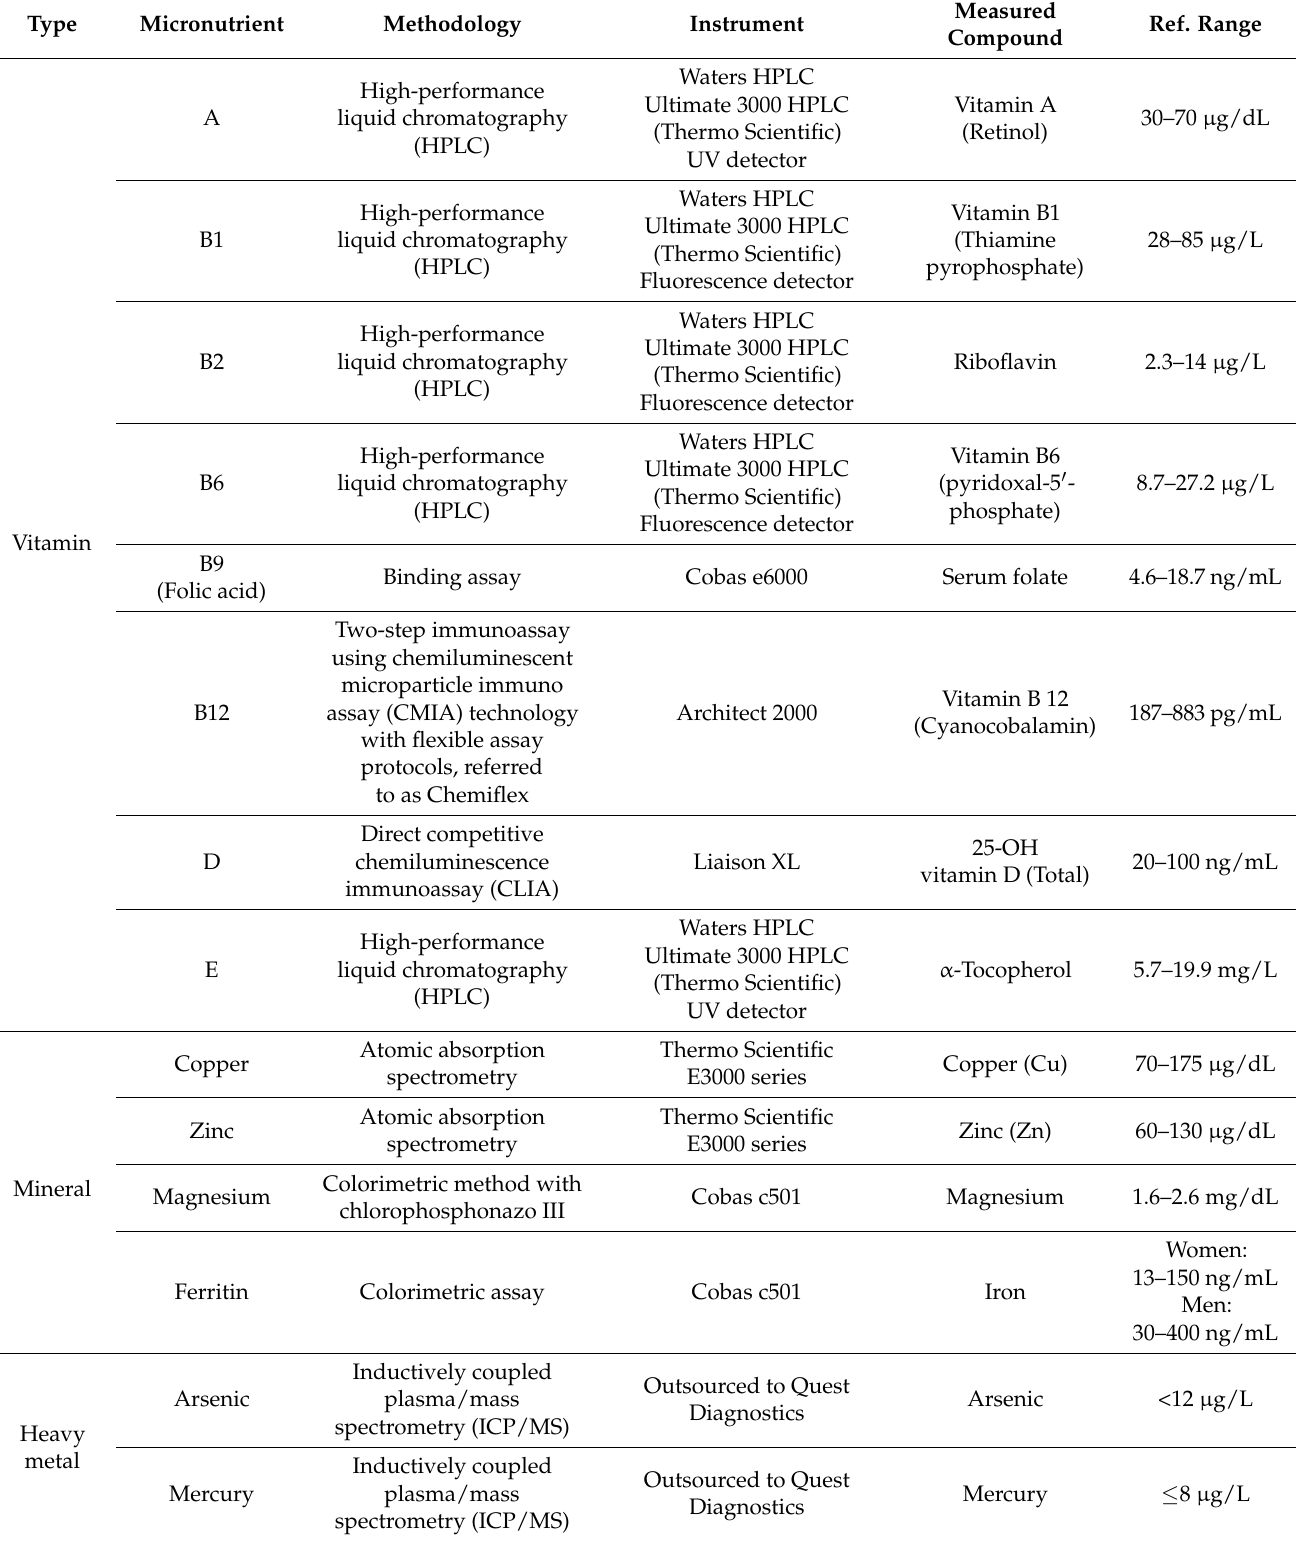
Table A1. List of Laboratory Tests